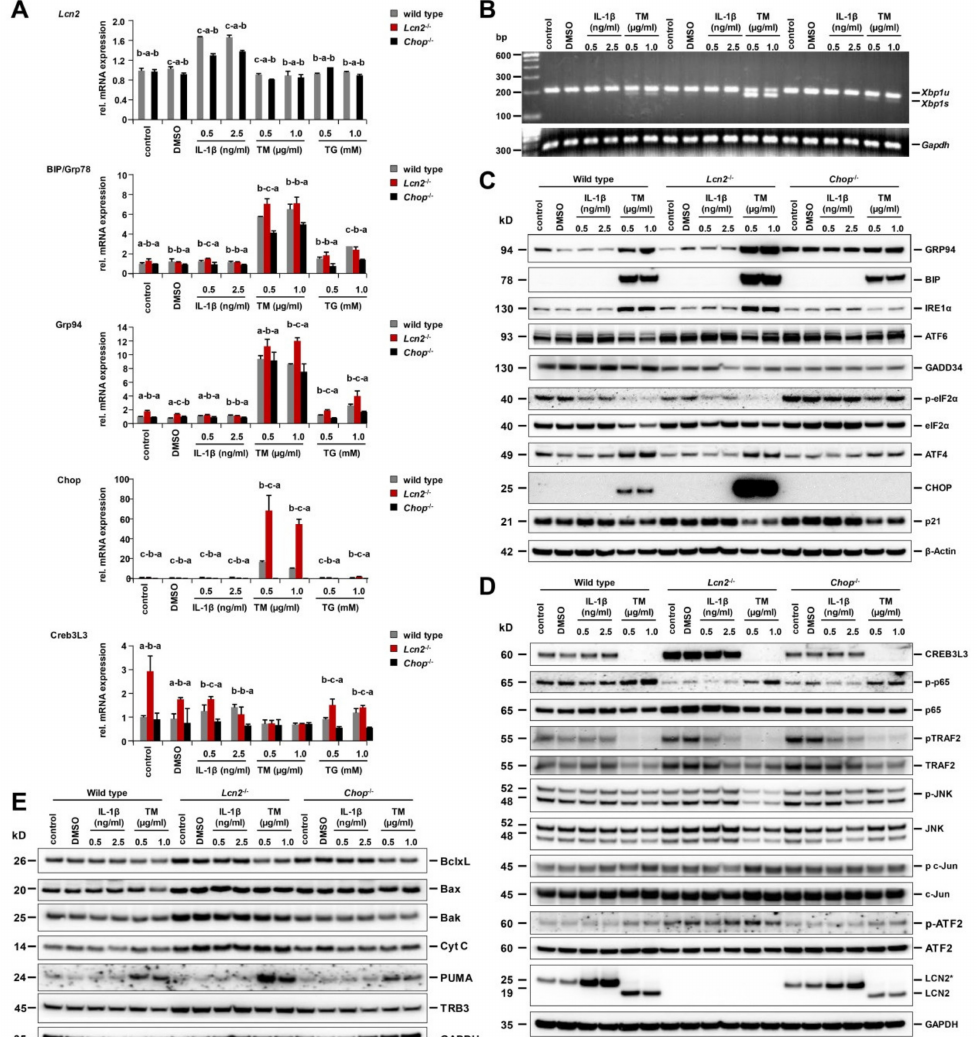
Figure 4. Lcn2 − / − hepatocytes reflecting strongest ER stress responses. ( A ) Real-time quantitative polymerase chain reaction (RT-qPCR) showing Lcn2 mRNA and ER stress-markers Bip / Grp78 , Grp94 , Chop , and Creb3L3 upon 24 h incubation with IL-1 β , tunicamycin (TM), and thapsigargin (TG). IL-1 β significantly induced Lcn2 mRNA expression, while Bip / Grp78 , Grp94 , and Chop mRNA levels were also markedly increased by TM or TG stimulation, while Lcn2 − / − hepatocytes showed the highest levels. Additionally, the Lcn2 − / − hepatocytes possessed already high basal levels of Creb3L3 . Details about the statistics are given in Supplementary Table S6. ( B ) Semi-quantitative PCR depicting unspliced ( Xbp1u ) and spliced Xbp1 ( Xbp1s ) mRNA. Lcn2 − / − hepatocytes incubated with TM showing the most significant amounts of Xbp1s . ( C ) Western blot analysis of ER stress marker proteins GRP94, BiP, IRE1 α , ATF6, GADD34, p-eIF2 α , eIF2 α , ATF4, and CHOP with β -actin as loading controls. Lcn2 − / − hepatocytes showed the highest ER stress responses with huge amounts of CHOP, while Chop − / − hepatocytes increased higher baselines of p-eIF2 α with decreased GADD34 and other UPR signaling proteins. ( D ) TM-induced ER stress was showed to activate and cleave CREB3L3 / CREBH. TM activated NF- κ B p65, TRAF2 / JNK / c-Jun, and further inhibited LCN2 glycosylation, as evidenced by shifting of the LCN2 molecular weight, with GAPDH as loading controls. ( E ) TM altered expression of Bcl2 family proteins, Lcn2 − / − hepatocytes were clearly demonstrated to decrease Bcl-xL, and increase Bax, Bak, and PUMA with higher Cytochrome c levels. GAPDH was applied as loading